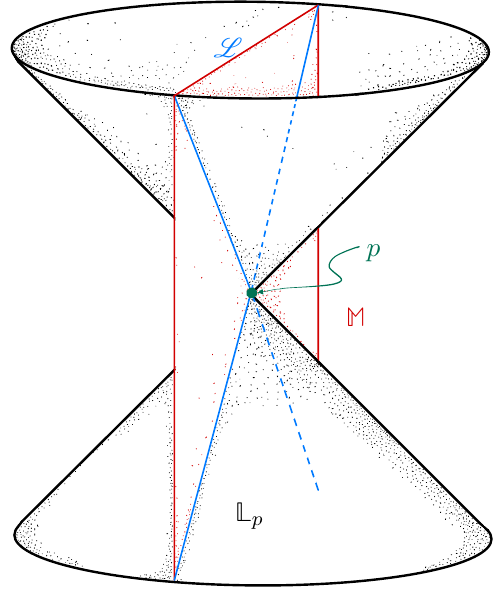
Figure 3 . The lightcone L at p ∈ M as the intersection L p ∩ M